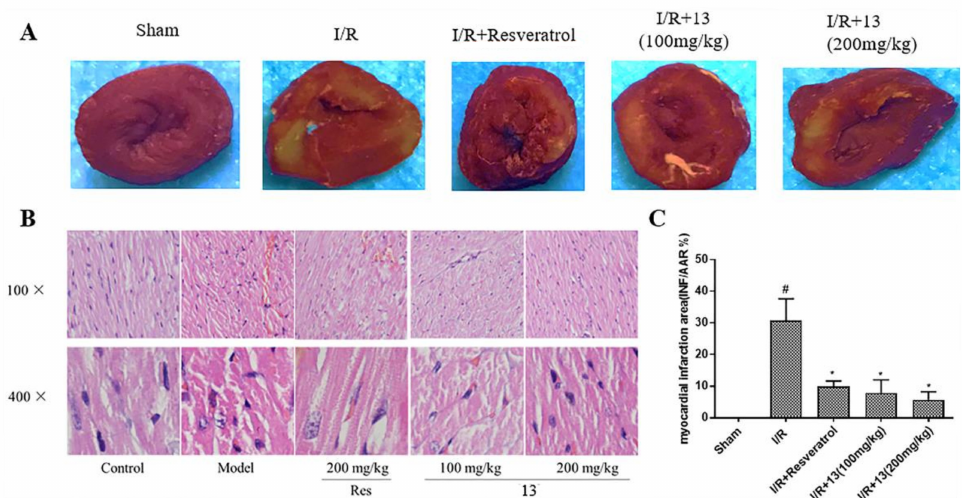
Figure 10. Effect of resveratrol, low-dose 13, and high-dose 13 on I/R-induced myocardial infarction. ( A ) TTC-stained images of rat heart sections from each group. ( B ) Pathological morphology of the myocardial tissue of rats with myocardial I/R injury. Heart tissues were stained with HE and visualized under a light microscope at 100 × and 400 × magnifications. ( C ) The percentage of infarct area in the area at risk in each group. Values were determined as means ± standard error. # p < 0.05 vs. sham group. * p < 0.05 vs. I/R